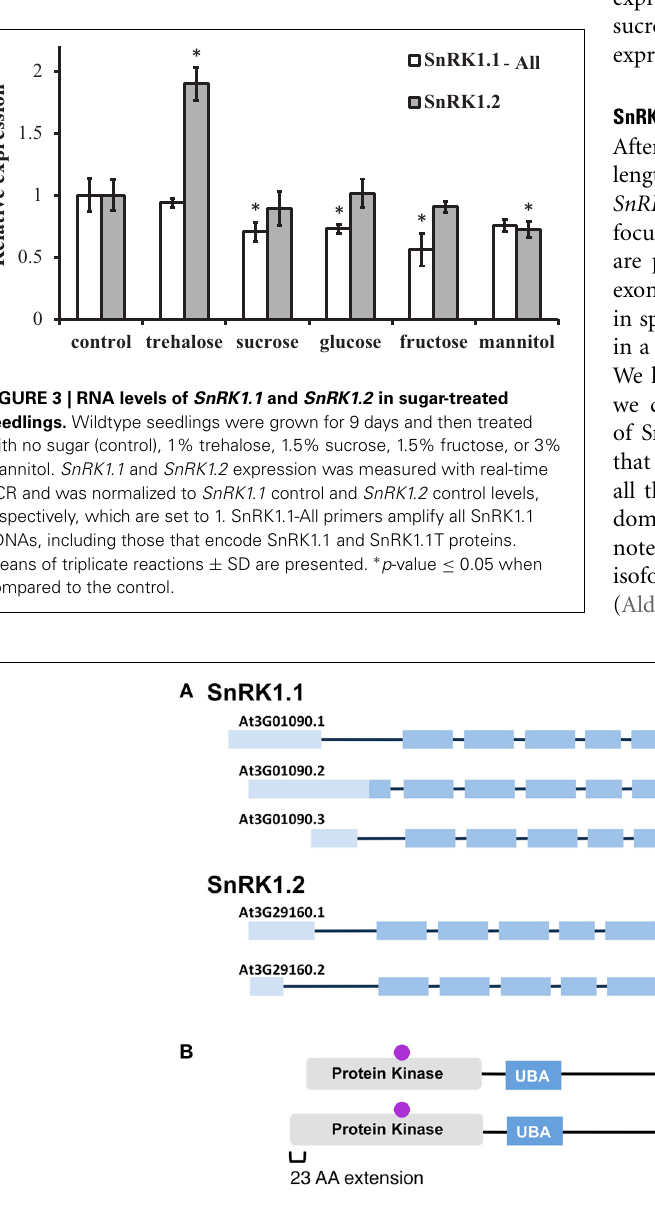
FIGURE 4 | Maps of SnRK1 Isoforms and Domain Structures. (A) The reported intron-exon maps of SnRK1 genes. Dark boxes denote exons while light boxes denote 5 (cid:3) and 3 (cid:3) UTRs. (B) SnRK1 kinases contain 3